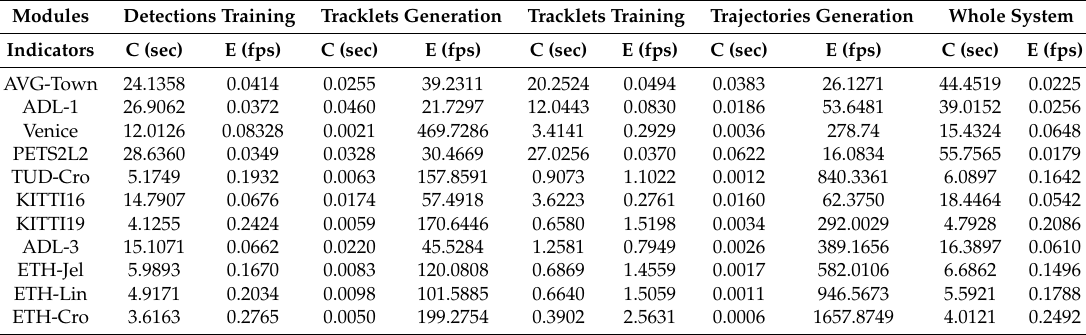
Table 5. Specific execution efficiency of proposed MOT system. Time consumption (C) and execution efficiency (E) of the whole MOT system and main modules are